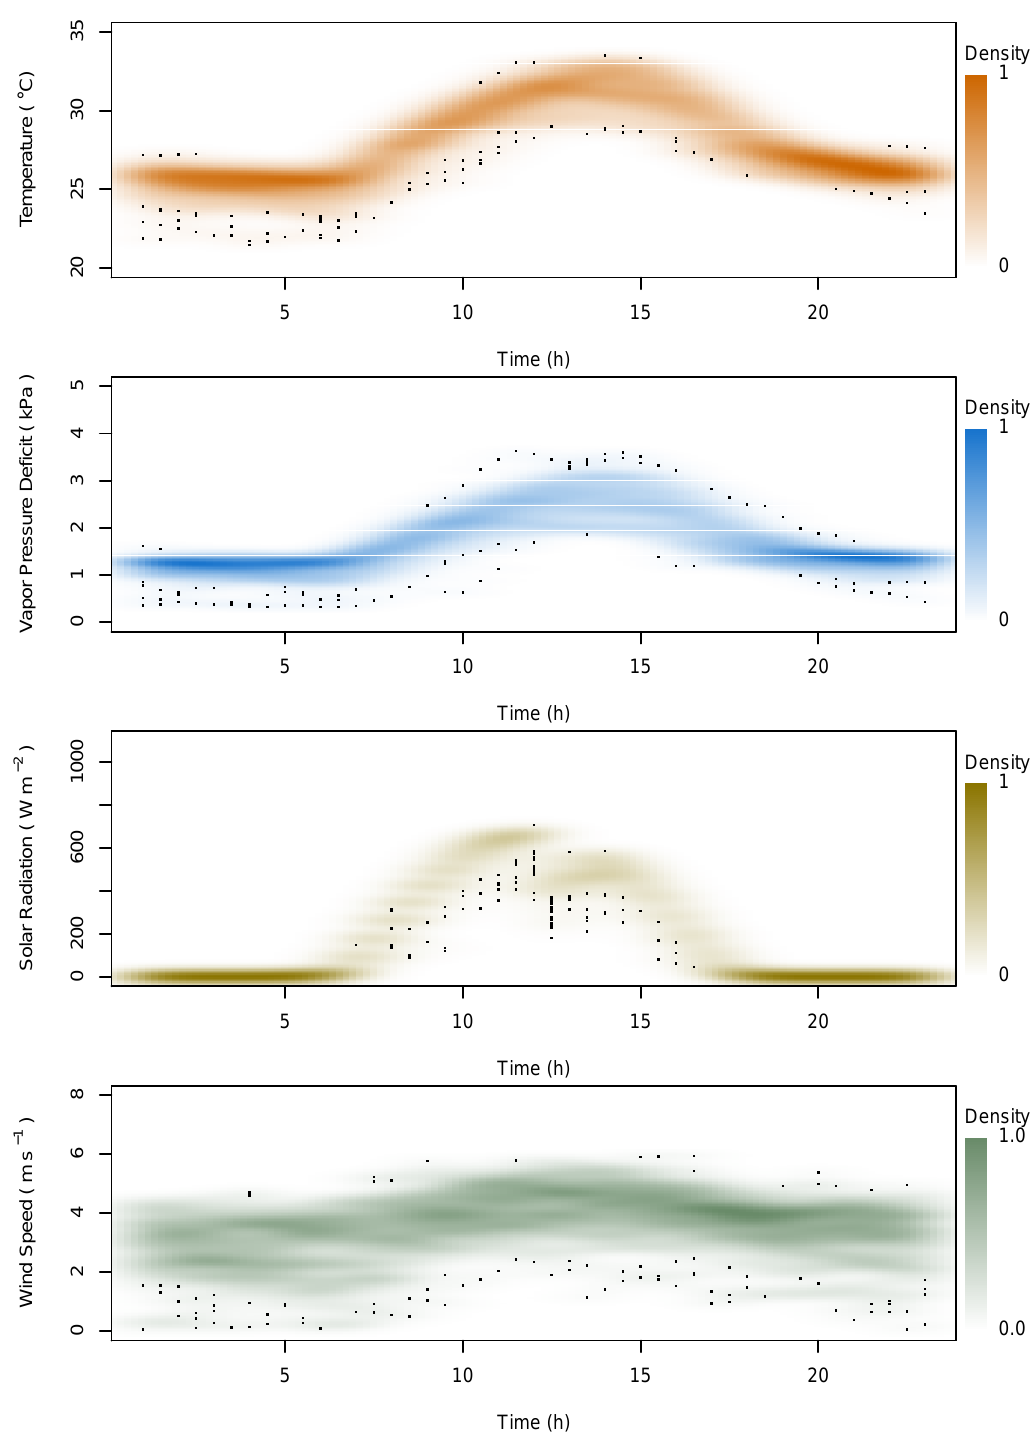
Figure 5. Density plots from the meteorological measurements during the study period at Palo Verde National Park, Costa Rica. Data recorded by the meteorological station of Palo Verde research station. The dots represent the first 50 points with lower densities among all measurements. Detailed data showed in